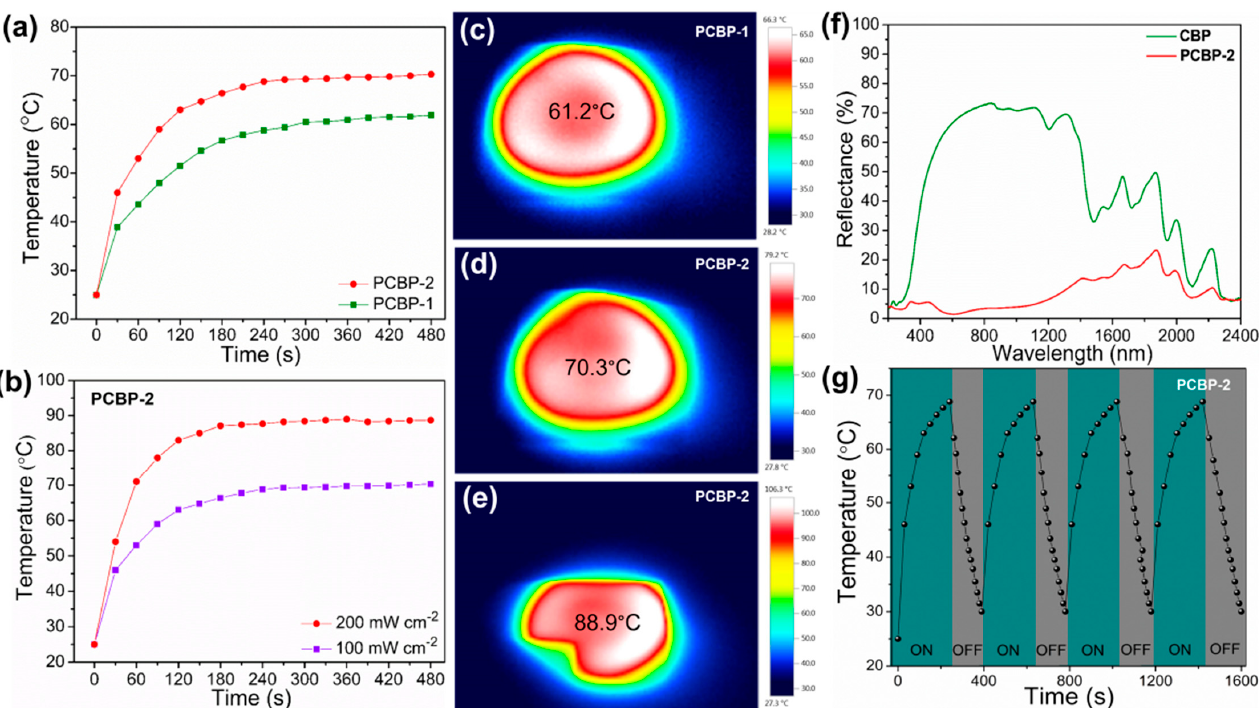
Figure 7. ( a ) The temperature changing curves of PCBP-1 and PCBP-2 surfaces under 100 mW cm − 2 solar illumination; ( b ) the temperature changing curves of the PCBP-2 surface under different optical concentrations; ( c , d ) infrared images of PCBP-1 and PCBP-2 surface under 100 mW cm − 2 illumination; ( e ) infrared images of PCBP-2 surface under 200 mW cm − 2 illumination. ( f ) Reflection spectra of the pristine CBP and PCBP-2 in the wavelength range of 200–2400 nm; ( g ) the temperature change of the PCBP-2 during four heating/cooling cycles.